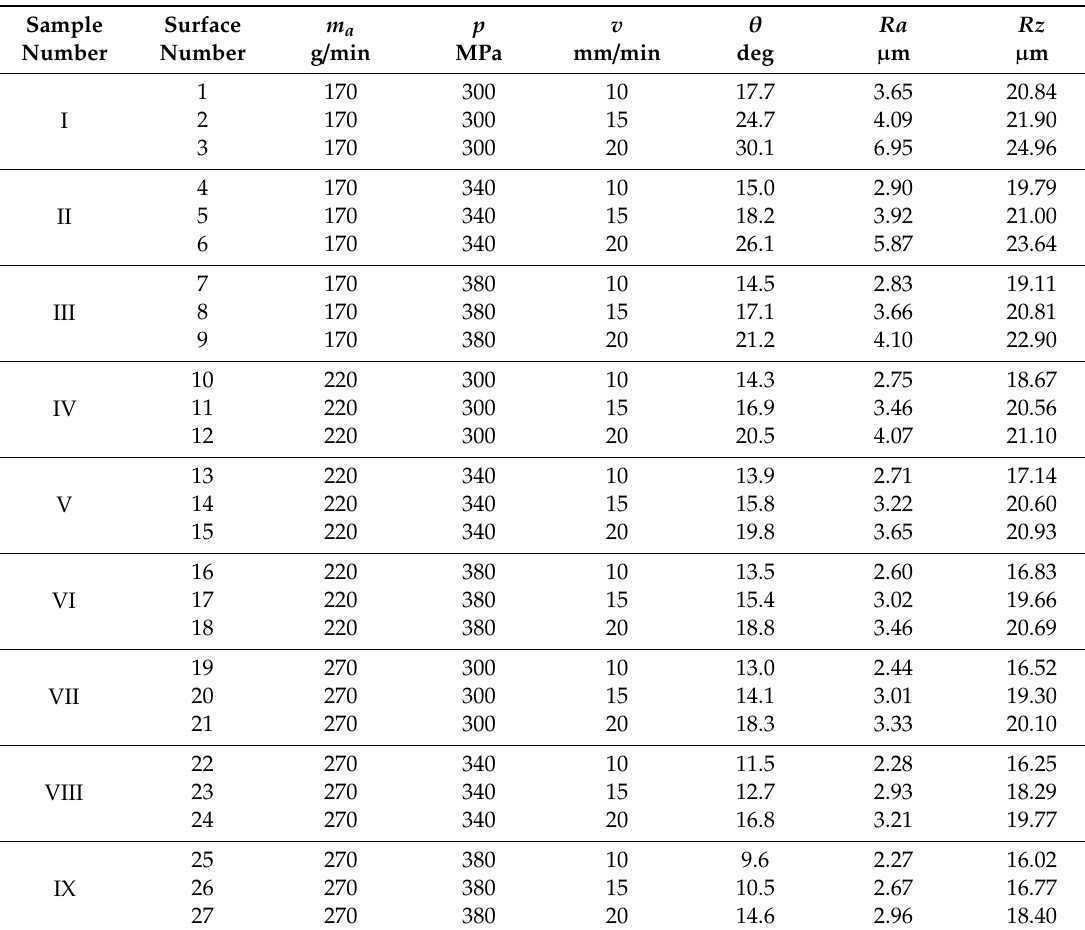
Table 4. Measured values of declination angle θ and roughness characteristics Ra and Rz on the cut walls at samples with a thickness of 40